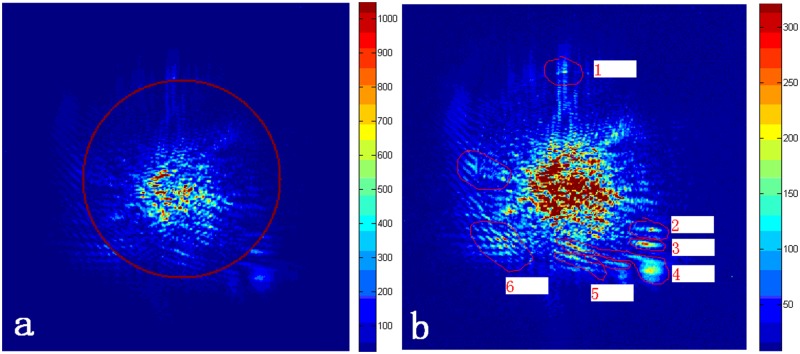
Analysis of the texture characteristics of the splicing region.(a) The position of the splicing ring. (b) The mosaic feature area.